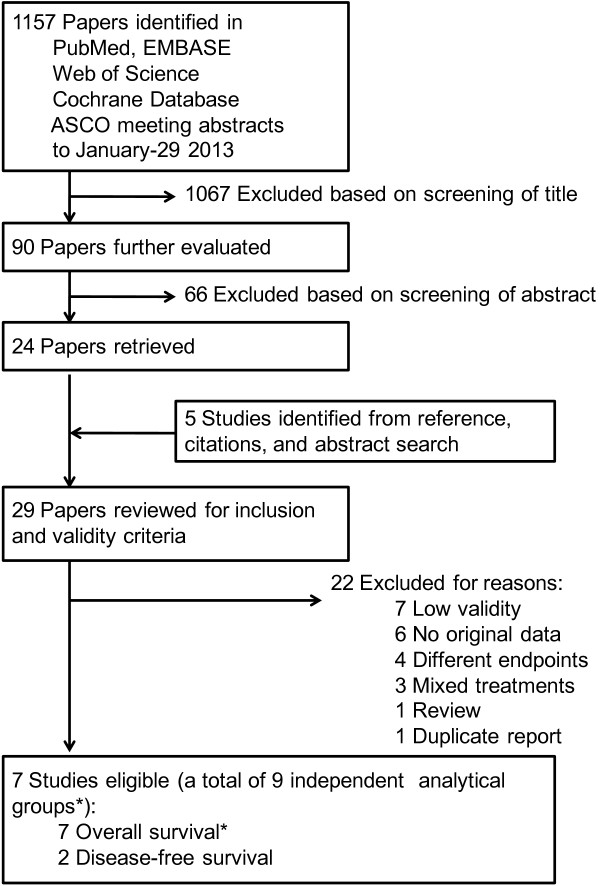
The literature search process. Validity required that either the comparison groups were balanced for relevant prognostic factors or the reported results were adjusted for these prognostic factors (Refer to the “Methods” section). *One study includes 3 analytical groups in overall survival.